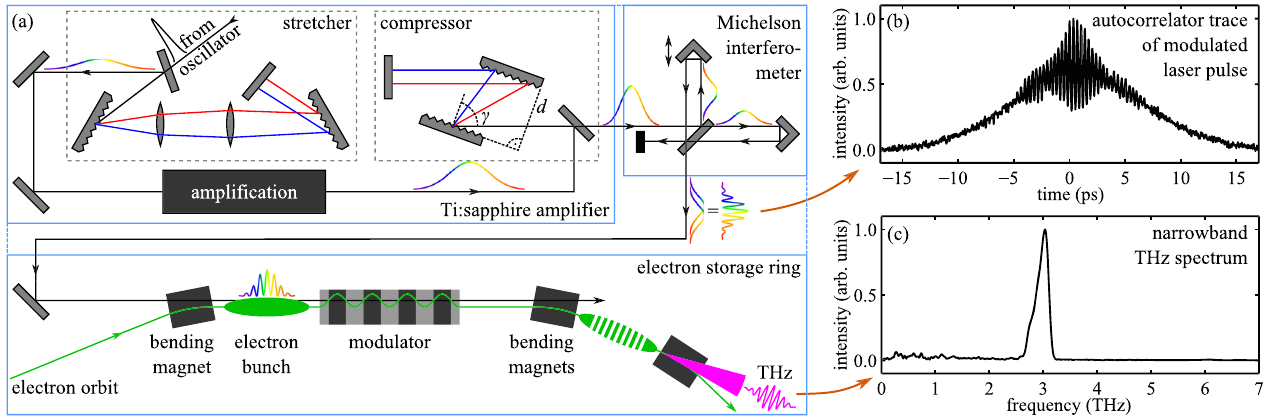
FIG. 1. Sketch of the chirped-pulse-beating setup used for the generation of narrowband laser-induced CSR at the electron storage ring DELTA in Dortmund, Germany, (a) and examples of a recorded laser pulse shape (b) and the corresponding narrowband THz spectrum